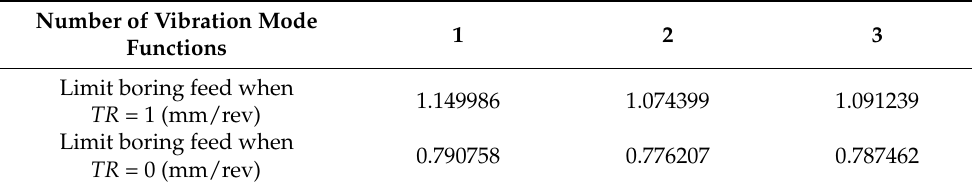
Table 3. Effect of the number of vibration mode functions on the limit boring feed of the rotated composite material boring system ( ψ = 1 and L/d = 10).